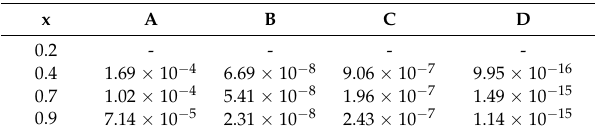
Table 2. Parameters used to fit the resistivity data (H = 0 kOe) of the Mn 3 Zn 1-x Co x N (x = 0.4, 0.7 and 0.9) compound.